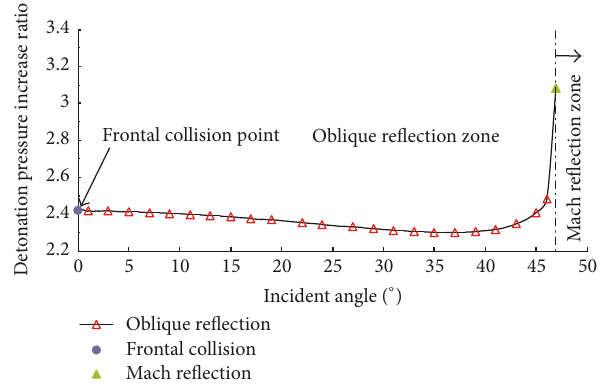
Figure 3: Relationship between the detonation pressure increase ratio and incident